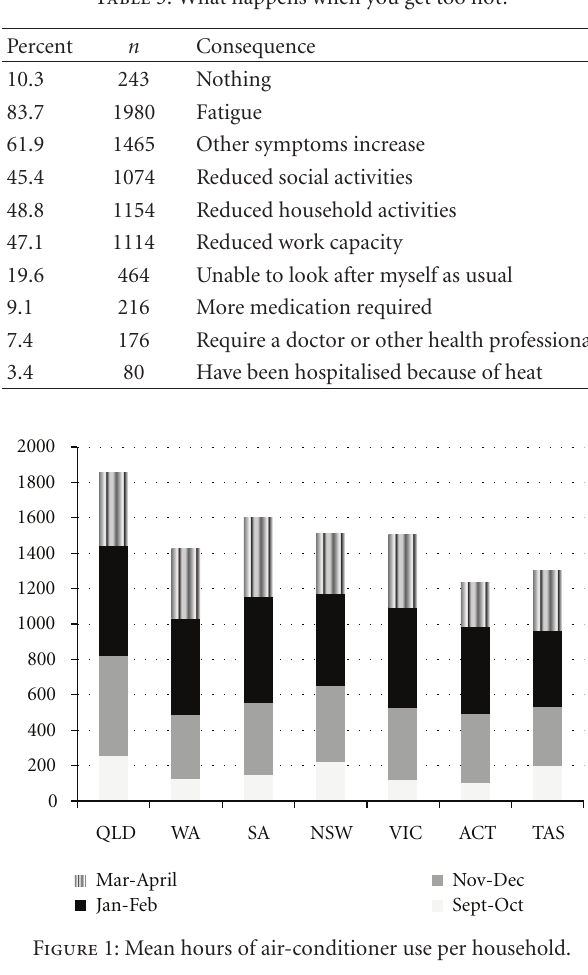
professional visits (7.4%), and hospitalisation (3.4%). Totals exceed 100% as categories were not mutually